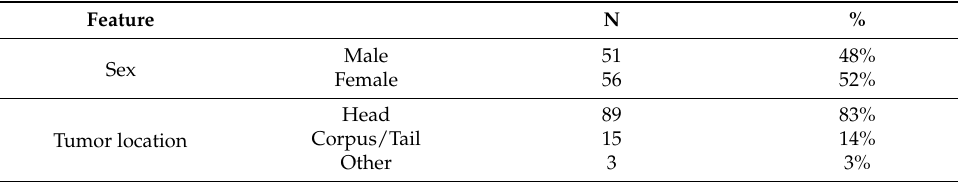
Table 1. Summary of basic clinicopathological